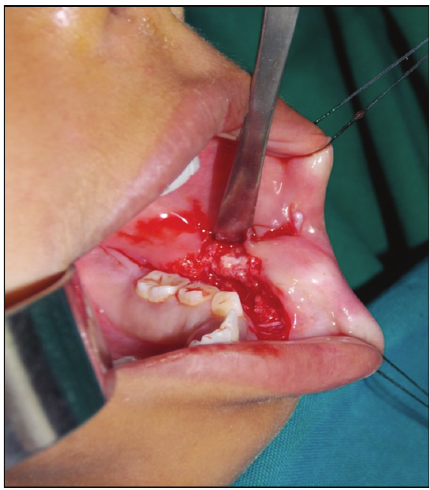
Figure 3: Bits of specimen for histopathological examination.